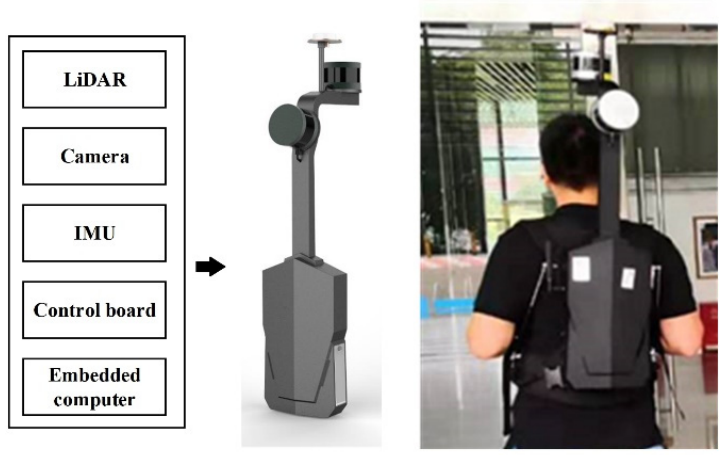
Figure 5. Multisensor 3D MLS backpack mapping system.